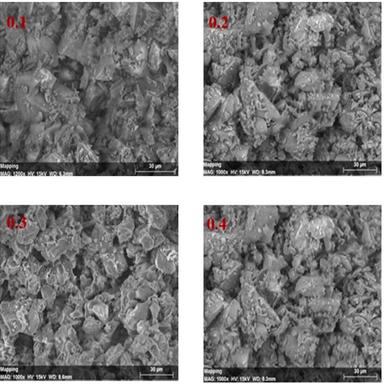
SEM microstructures of the Li4Si1-xTixO4 powder samples.